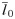
The influence of senescent mortality, mediated by age-independent mortality, on the relationship between l¯0 and e0 (in years).Shown are data points calculated from mortality trajectories where b0 and b1 > 0, c ≥ 0, and b0 = b1 = 0. (a) The effect of the level of senescent mortality (b0). (b) The effect of the rate of senescent mortality (b1). (c) The effect of age-independent mortality c.